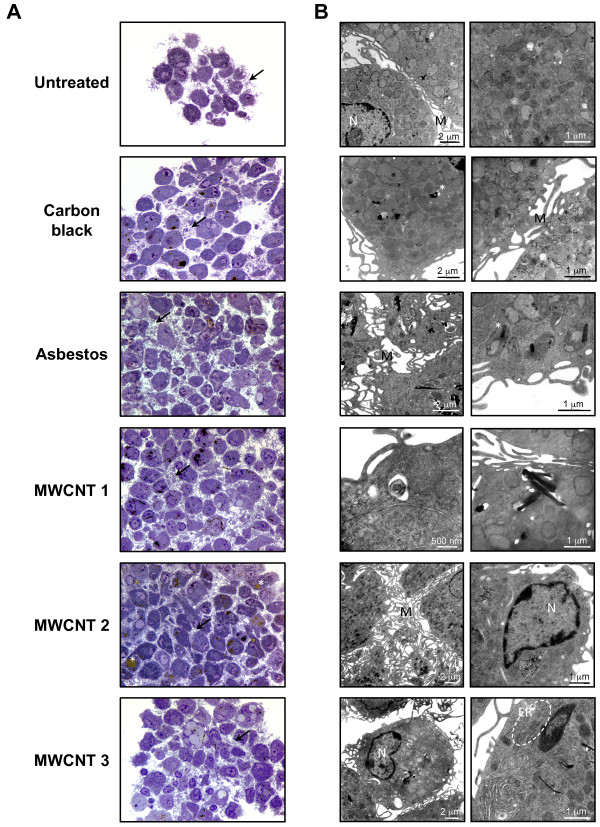
Morphology of epithelioid granulomas after 14 days of exposure to asbestos fibers or MWCNTs in 3D cultures. After 14 days, cells were fixed in situ, embedded in plastic, and sectioned. 0.5 μm sections were stained with toluidine blue (A) for light microscopy. Magnification: 1000×. Ultrathin sections were stained with uranyl-acetate/lead citrate for transmission electron microscopy (B). Untreated cells or cells exposed to 0.5 μg/ml (0.38 μg/cm2) of carbon black have short surface microvilli and well-preserved cellular organelles. Exposure to 0.5 μg/ml (0.38 μg/cm2) of asbestos fibers or commercial MWCNTs induces epithelioid granulomas characterized by compact cell aggregates with prominent interdigitating surface microvilli. Asbestos fibers or MWCNTs are usually localized in cytoplasmic vacuoles and cellular organelles are well preserved. Black arrow and M: microvilli, N: nucleus, *: vacuole containing particulates, ER: endoplasmic reticulum.